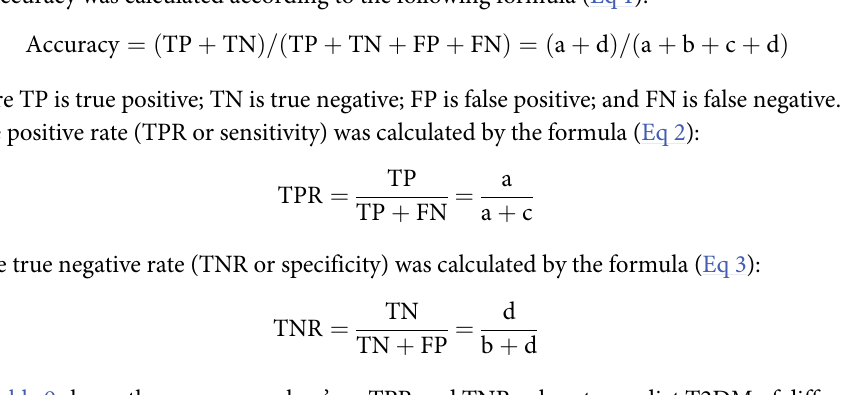
Predicting diabetes and dyslipidemia for the testing set using different ML models. A heat map was generated for all parameters (input and output), except for those that have either binomial or discrete values (gender and polymorphisms). TG is moderately associated with BS, and a strong correlation between LDL and TC is clearly presented (Fig 4). Pearson’s corre- lation (r, as shown on Y axis of Fig 4) was used as measure for correlations; r > 0.7 is consid- ered strong correlation, between 0.4 and 0.7 moderately correlated, and < 0.4 weakly correlated [64].